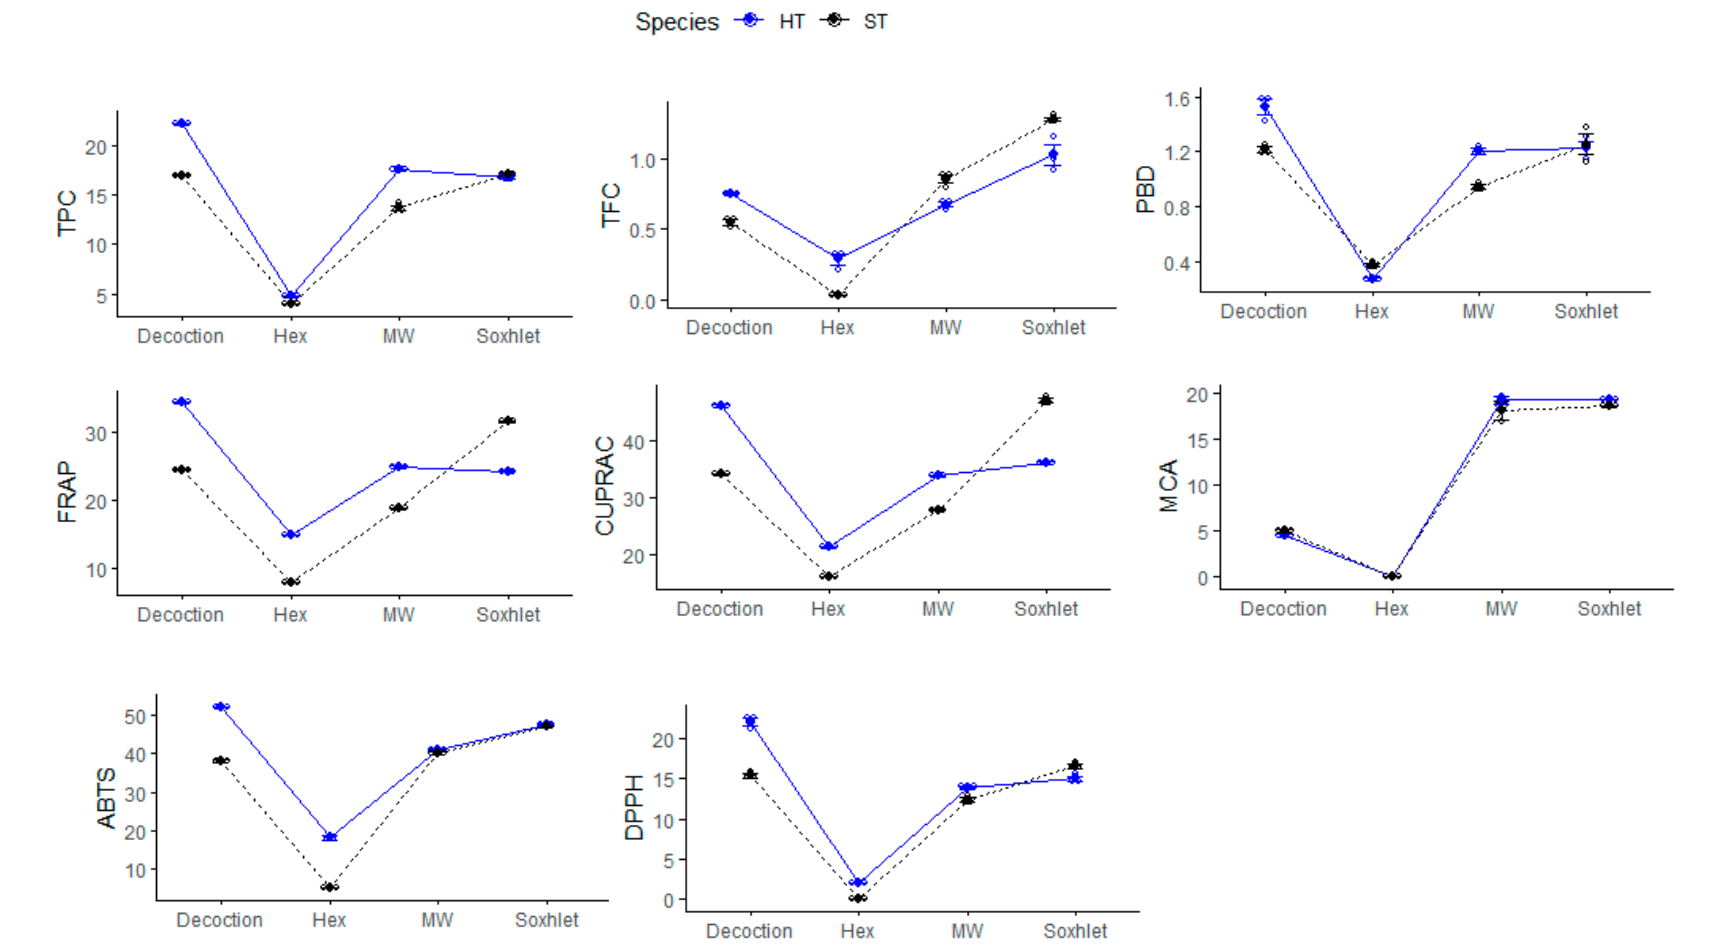
Figure 3. Dotplot for exploring the effect of extraction techniques on biological activities of pepper samples (HT: hot pepper; ST: sweet pepper).